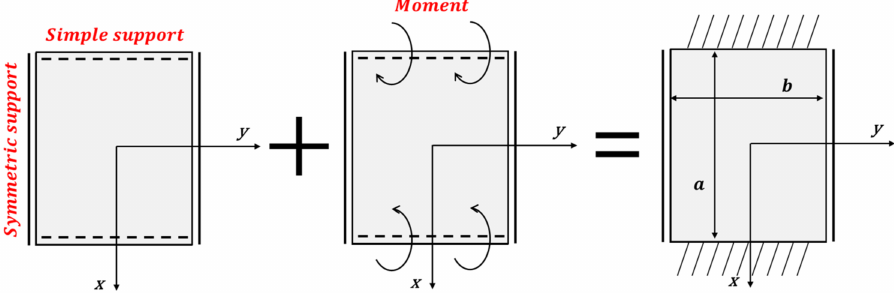
Figure 11. Implementation of a fixed support using the superposition